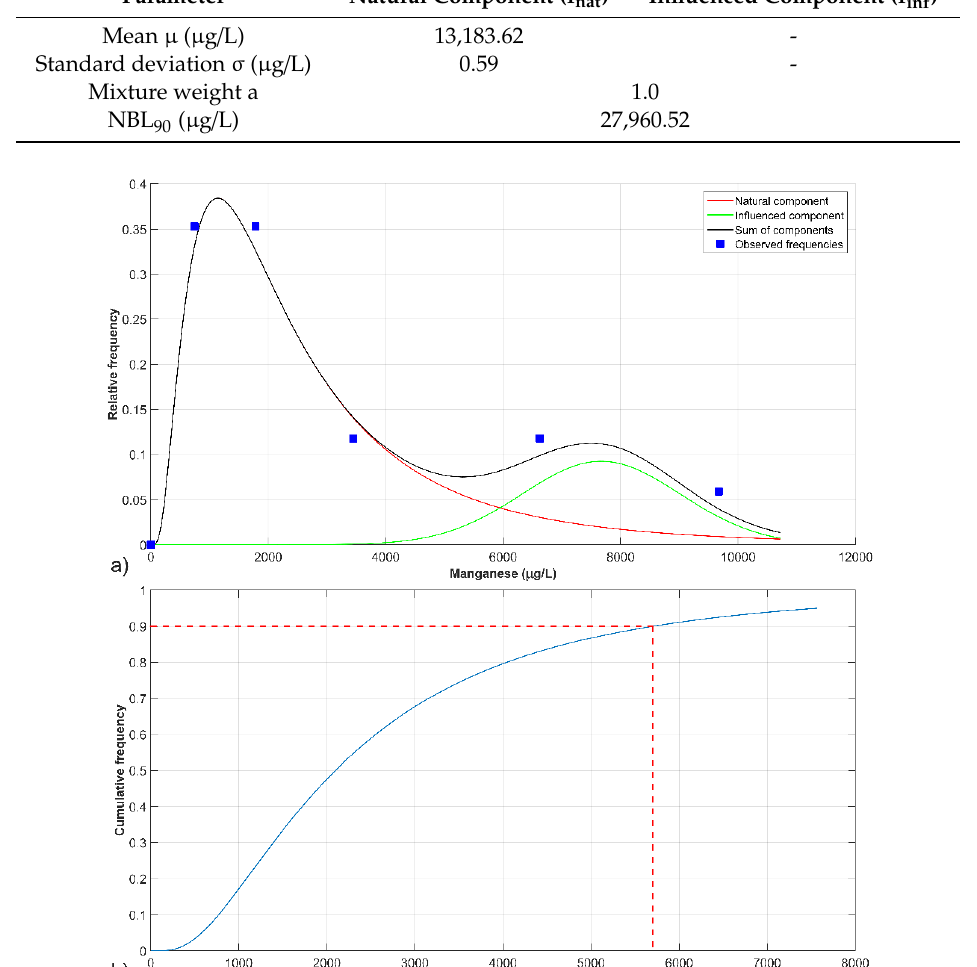
Table 3. GuEstNBL output: Results of the guided estimation procedure for manganese dataset. Parameter